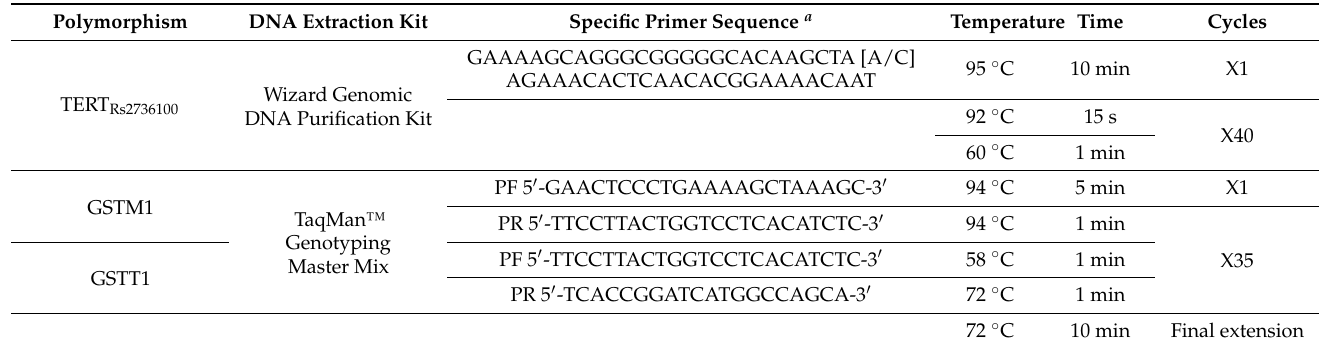
Table 1. Genotyping